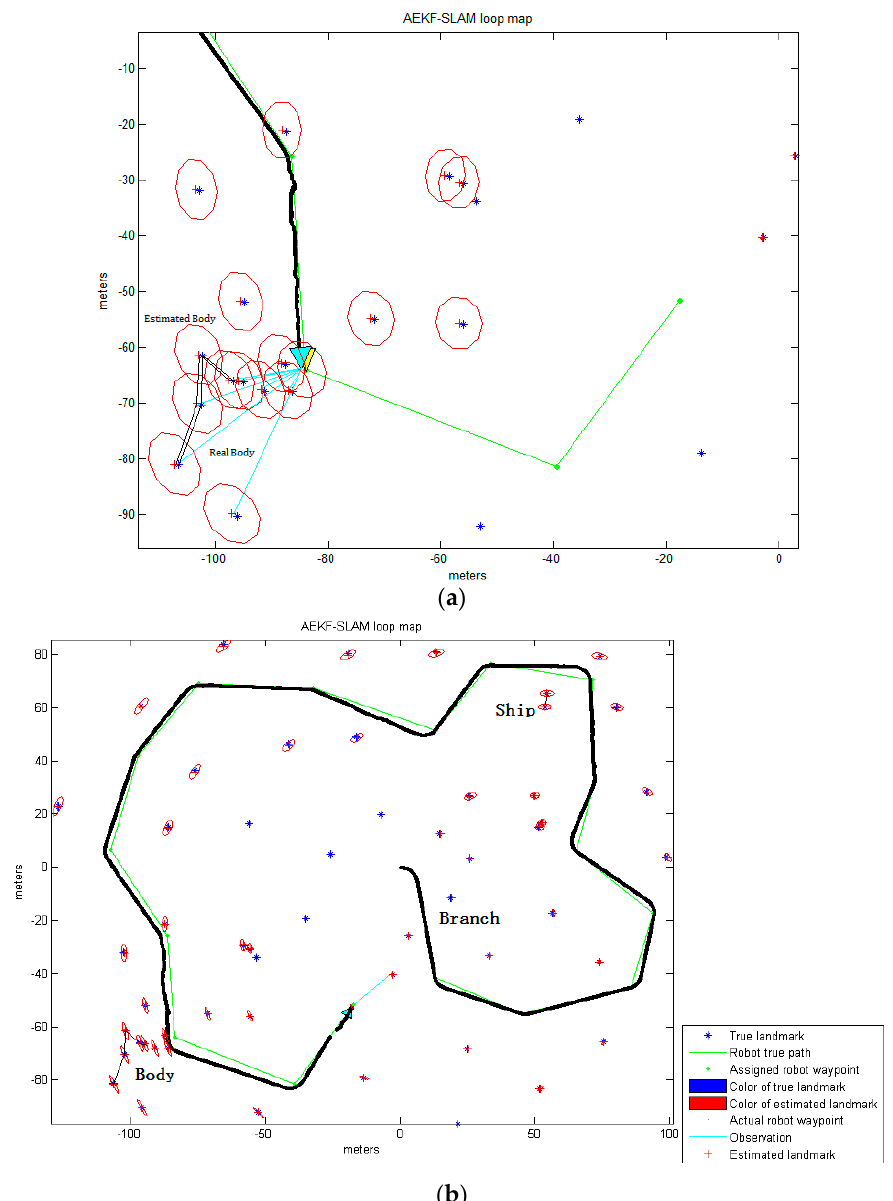
Figure 13. ( a ) The robot is observing the centroids of certain parts of the body before loop closure; ( b ) The final AEKF-SLAM loop map where the landmarks are detected by the improved Otsu TSM. The landmark point positions of the ship, branch and body estimated by the AEKF and the real ones detected by the improved Otsu TSM are shown in Table 10. Table 10. The landmark point positions of the ship, branch and body estimated by the AEKF and the true ones detected by the improved Otsu TSM.